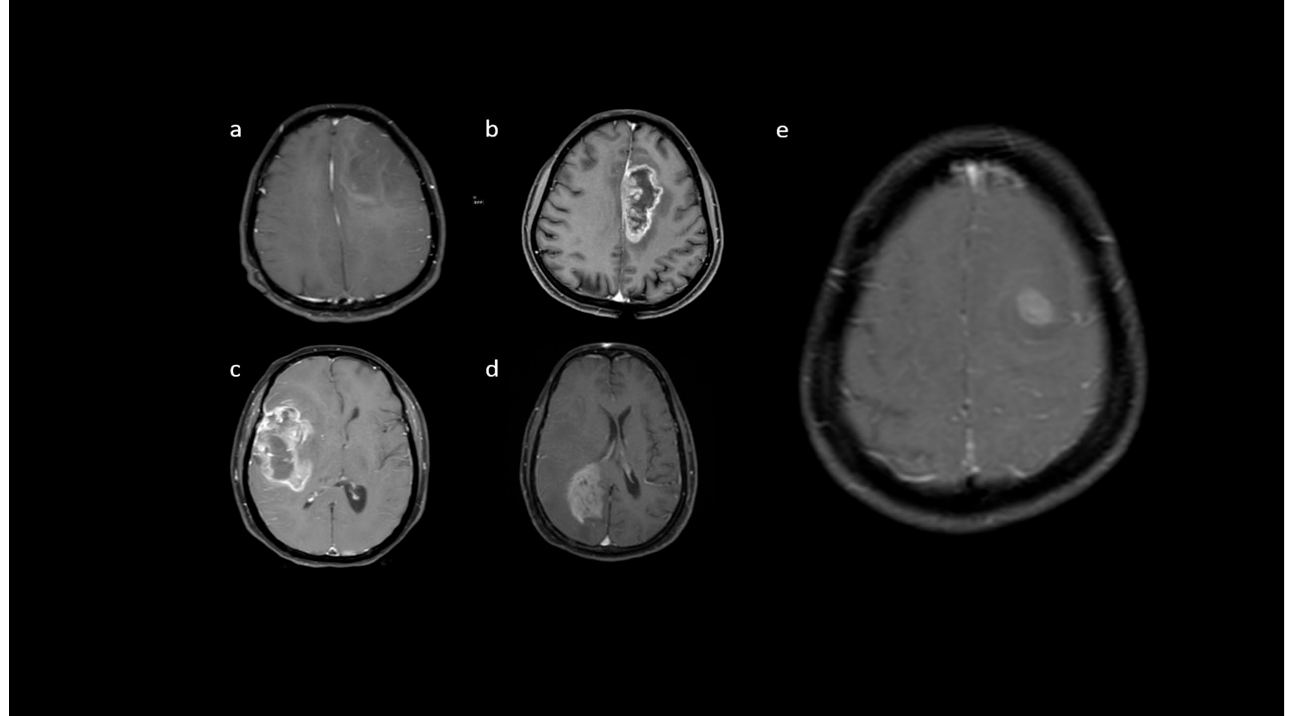
Figure 8. ( a – e ) Representative post-contrast T1 images showing various enhancement patterns: ( a ) no noticeable enhancement; ( b , c ) severe enhancement, ( d ) moderate enhancement pattern, and ( e ) mild enhancement.